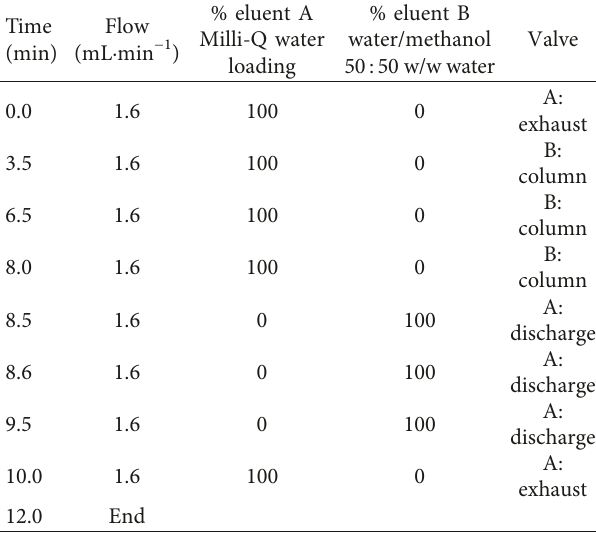
Table 2: Elution conditions employed in Gemini HPLC Column.